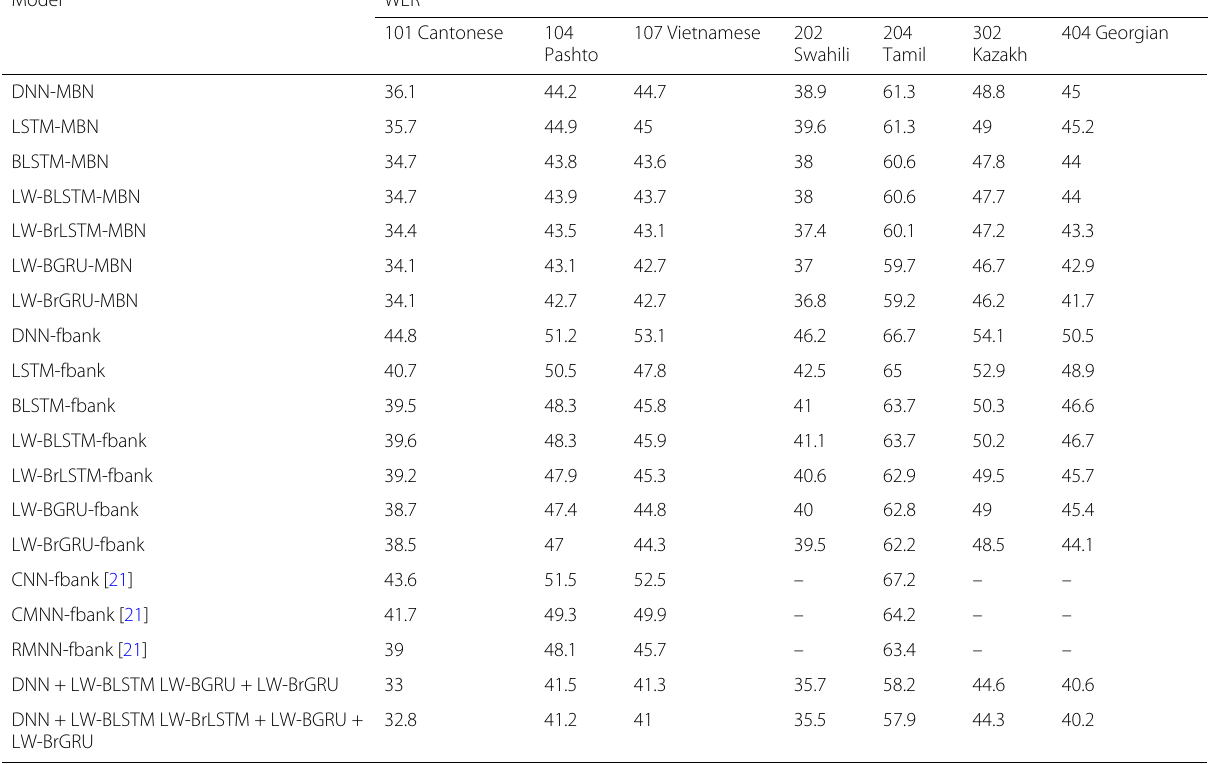
Table 13 WER (%) across all languages